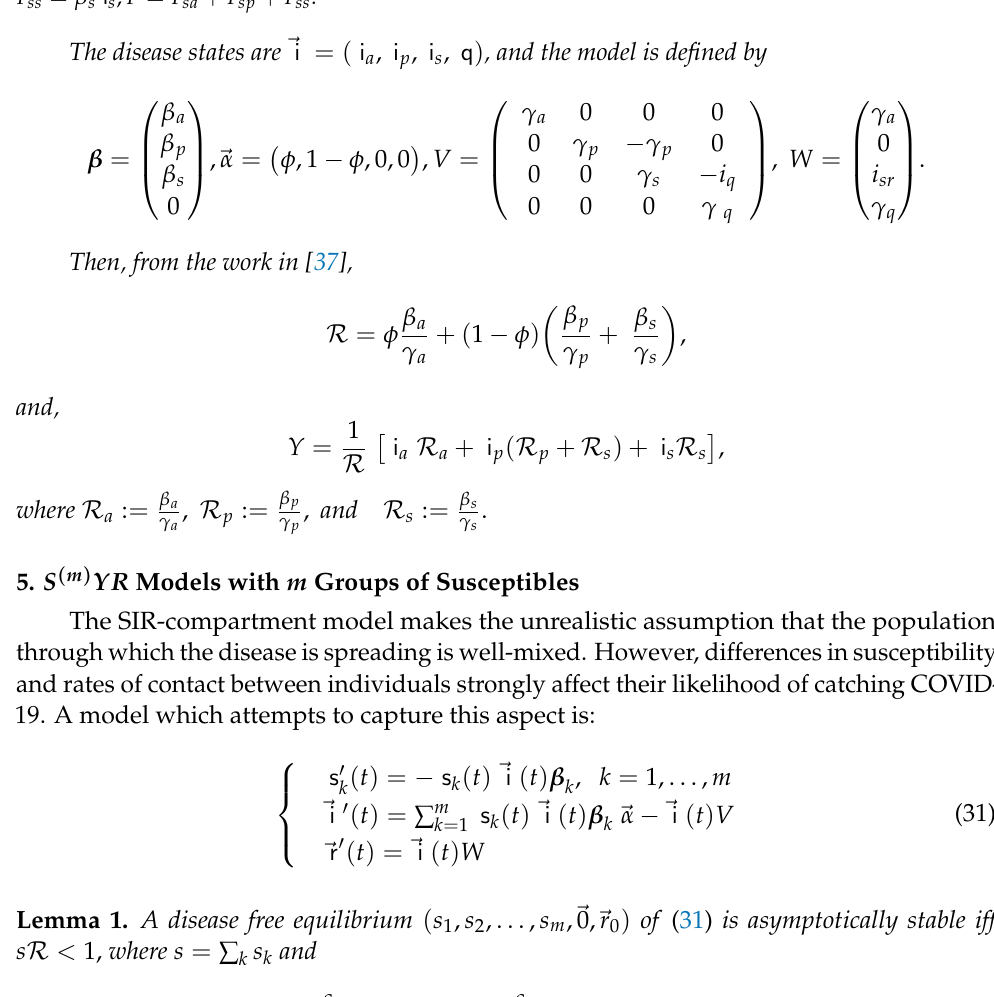
Figure 5. Flowchart of S I aps QR model. The forces of infection (rates) are F sa = β a i a , F sp = β p i p , F ss = β s i s , F = F sa + F sp + F ss